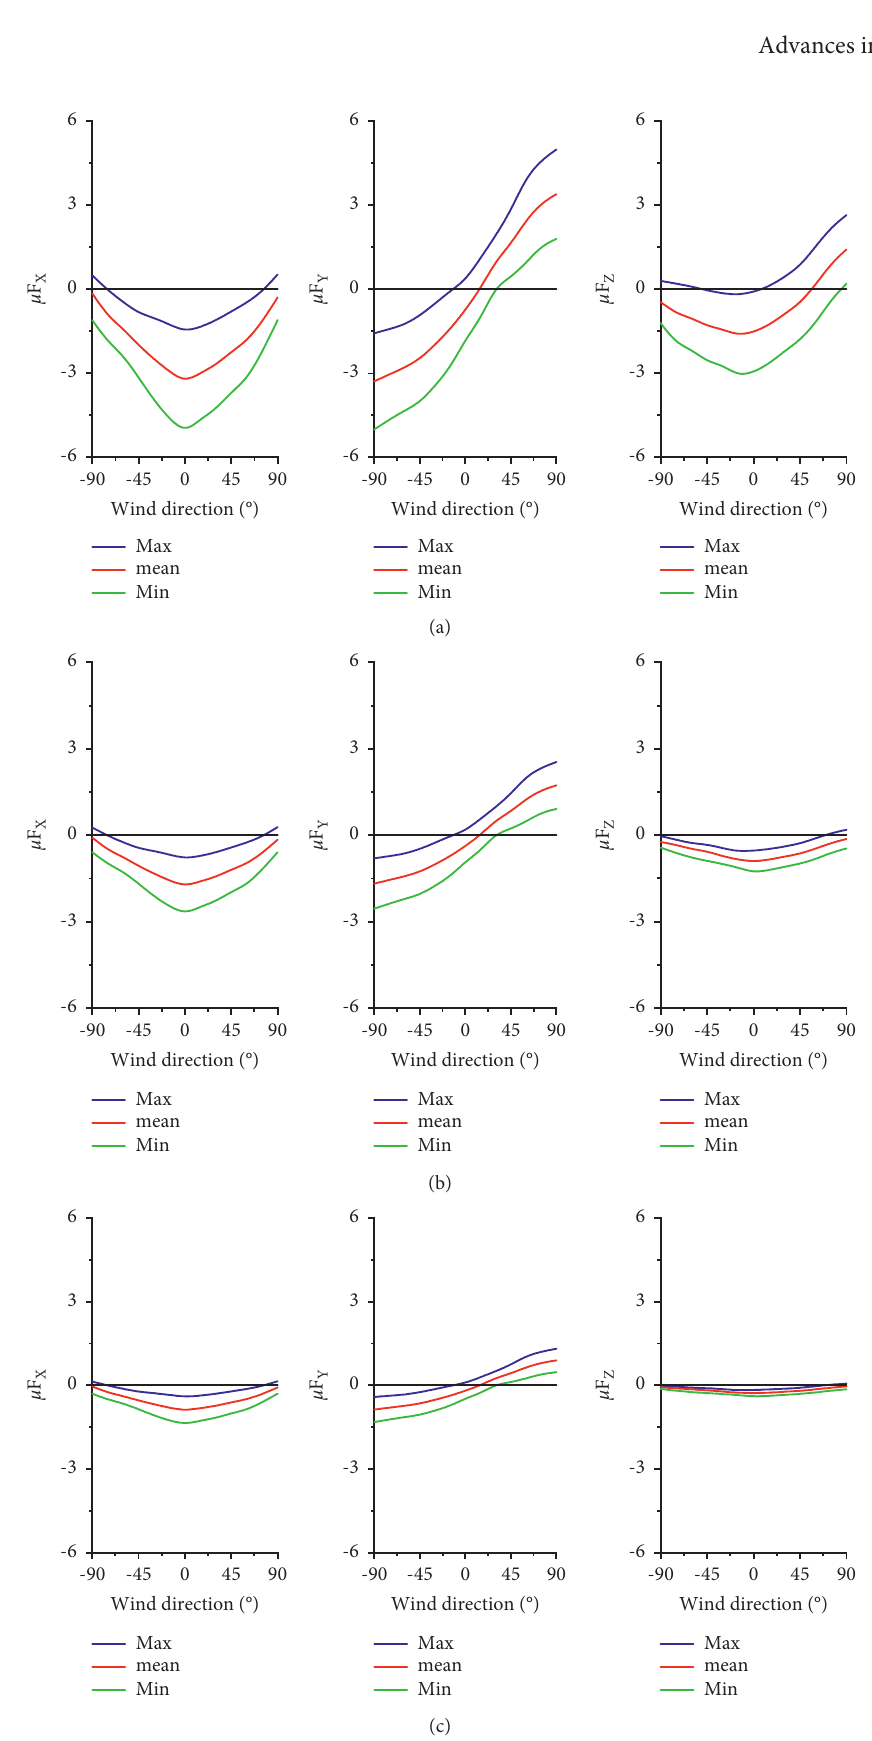
Figure 7: Variations of mean, maximum, and minimum wind force coefficients with wind direction for the different sections. (a) Section 1, (b) Section 4, and (c) Section